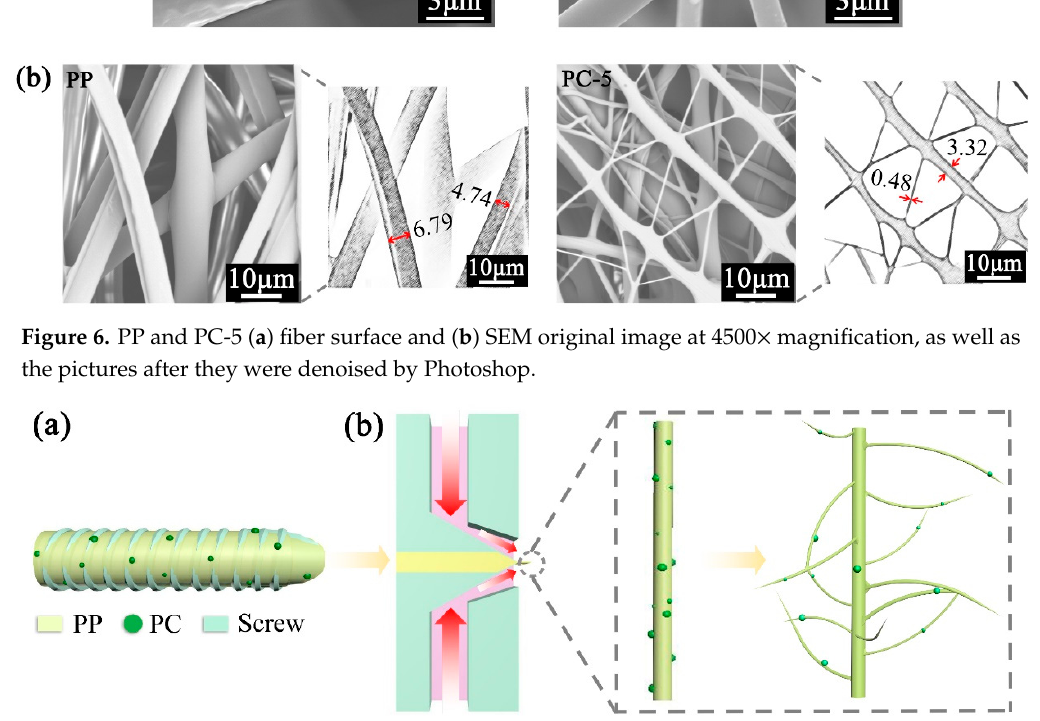
Figure 7. The pull-out process of PC to PP: PP and PC under the action of ( a ) high temperature screw shear force and ( b ) hot air.